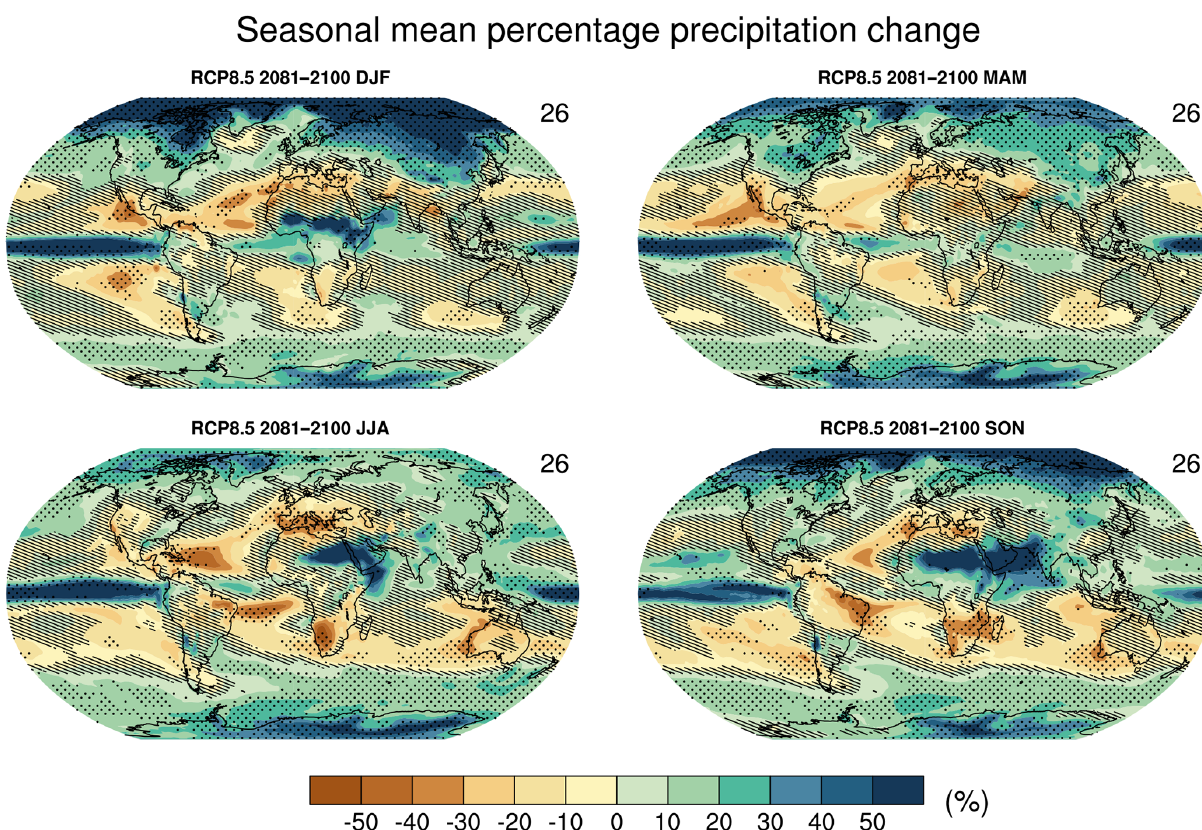
Figure 18. Global maps of seasonal mean change in precipitation from 1986–2005 (reference period) to 2081–2100 for the RCP8.5 scenario. Hatching indicates regions where the multi-model mean change is less than 1 standard deviation of the internal variability estimated from piControl simulations. Stippling indicates regions where the multi-model mean change is greater than 2 standard deviations of the internal variability and where at least 90% of models agree on the sign of the change. The numbers in the upper right of each panel indicate the number of models used. Similar to Fig. 12.22 of Collins et al. (2013) but only for one future time period. Produced with recipe_collins13ipcc.yml (see Sect. 3.4.3 for